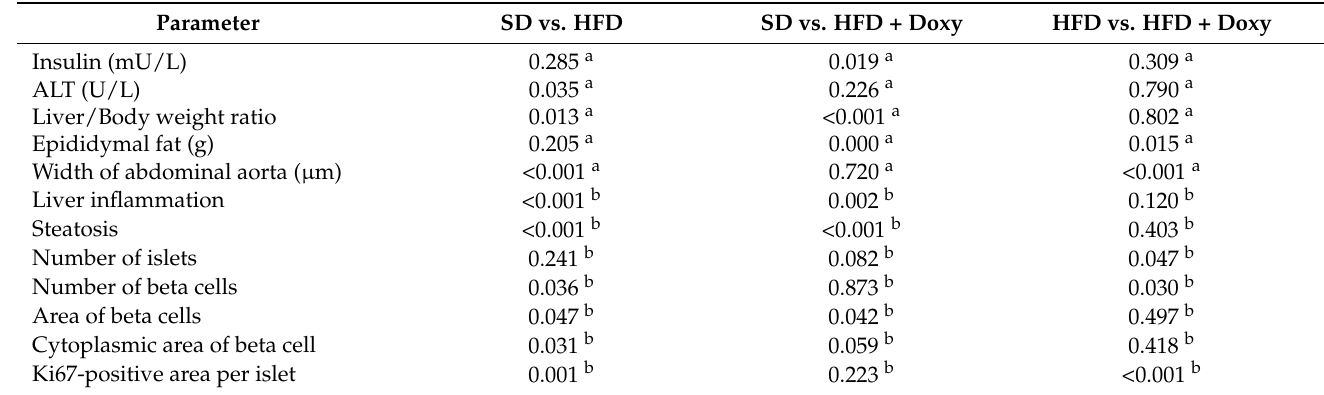
Table 2. Statistical comparison (post hoc) of various parameters between healthy (SD), high-fat diet (HFD), and high-fat diet and doxycycline (HFD + Doxy) mice